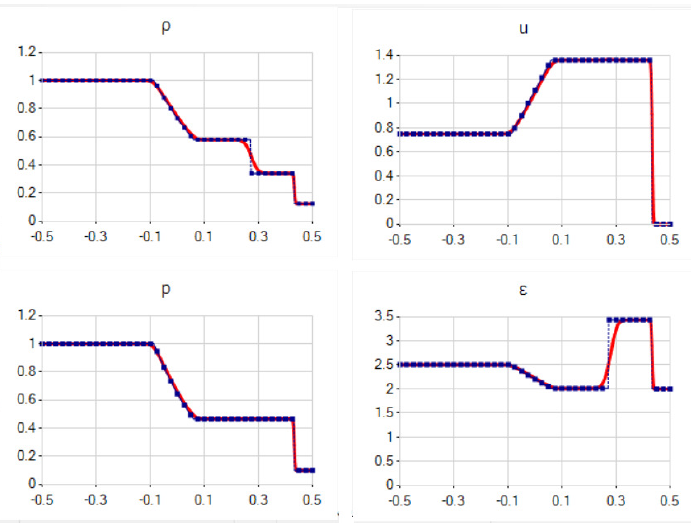
Figure 1. Test 1. Solutions for α = 0 . 2, β = 0 . 3 and N =